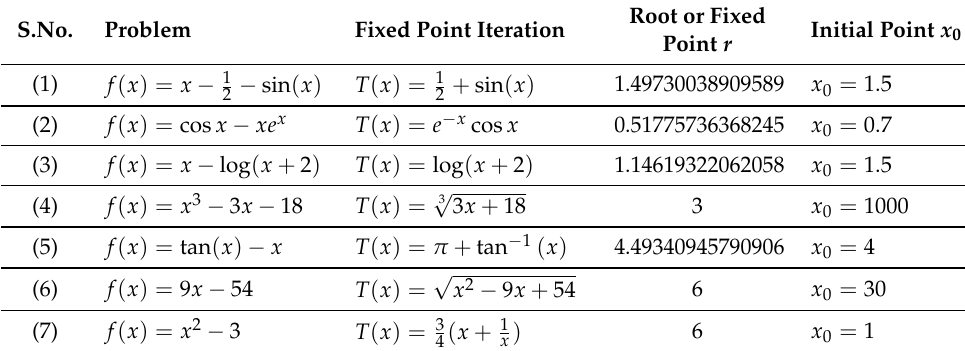
Table 3. Test problems for two-step and three-step methods. S.No.